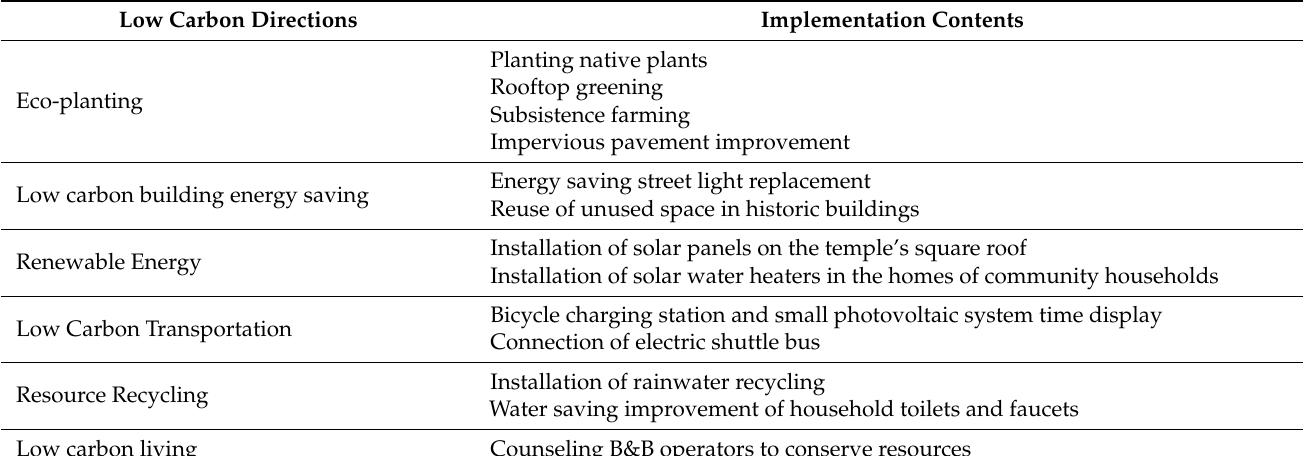
Table 2. List of contents of the final